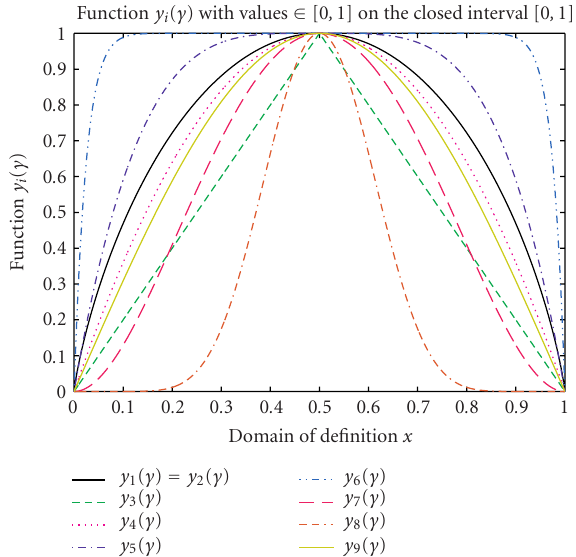
Figure 4.12. Comparison of the normalised functions y 1 , ... , y 9 on the simplex S 1 , that is, the closed interval